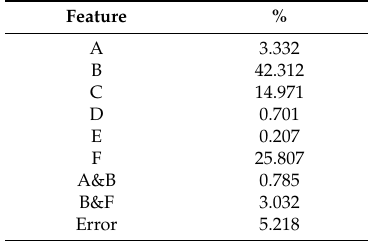
Table 3. Error reported by the ANOVA analysis and relative influence of the election of the input features on the global result when the Support Vector Machine (SVM) algorithm is applied. Inputs: